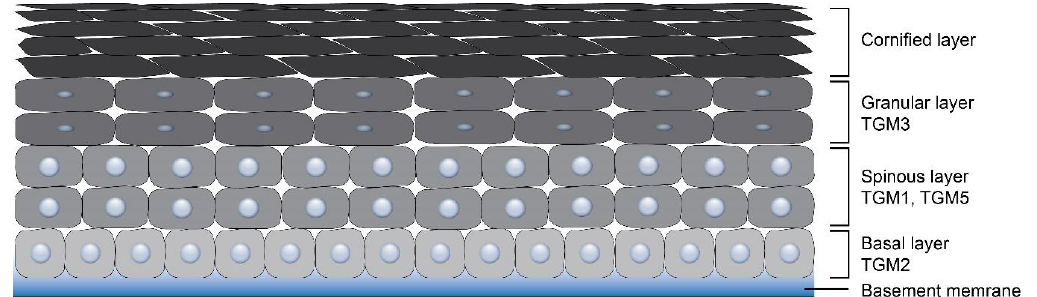
Figure 1. Distribution of transglutaminases (TGMs) in the epidermis.